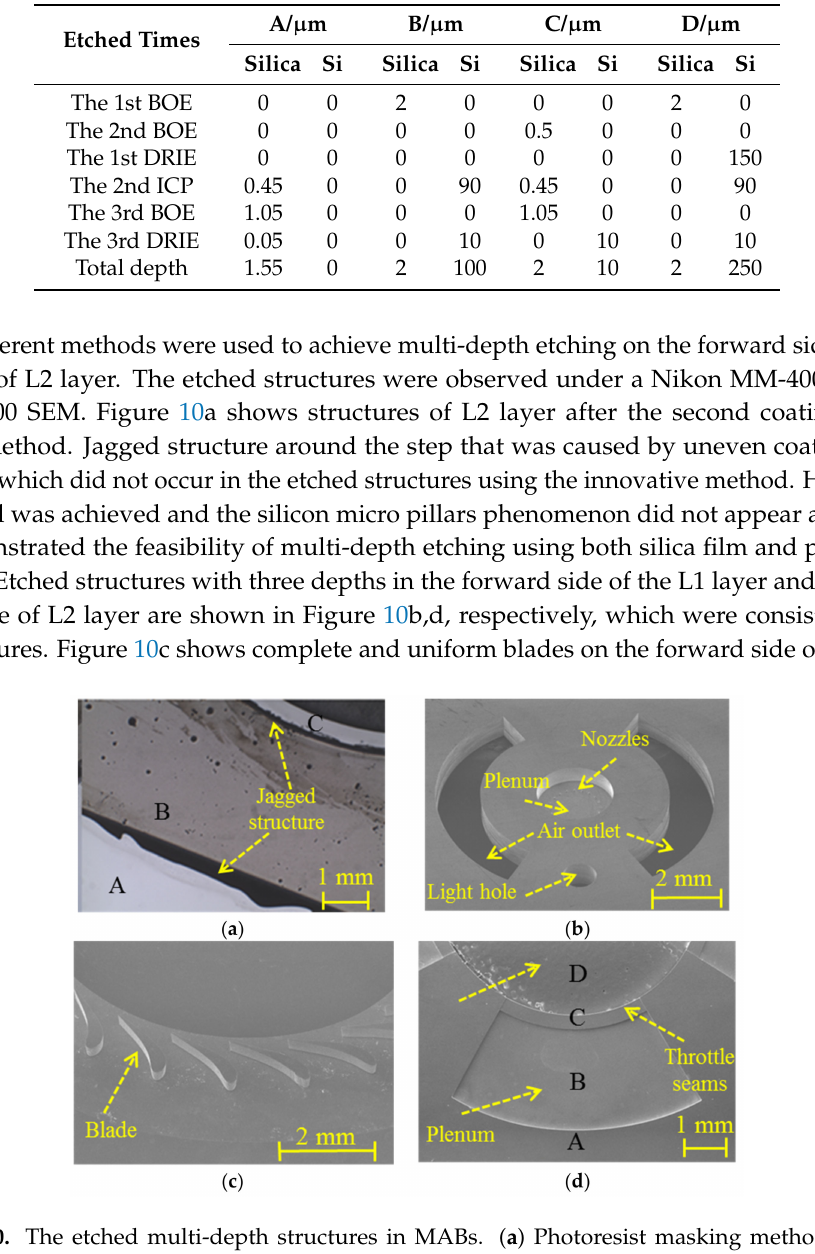
Figure 10. The etched multi-depth structures in MABs. ( a ) Photoresist masking method caused jagged structures; ( b – d ) Silica masking method achieved high-perpendicularity and integrated structures on forward side of L1 ( b ); forward side of L2 ( c ); and, aft side of L2 ( d